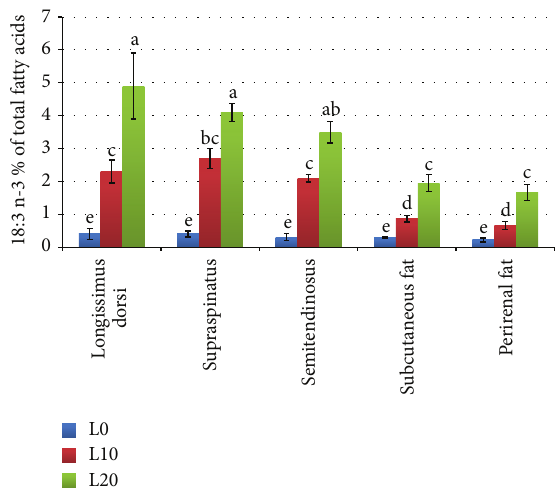
Figure 1: ALA (18:3 n-3) contents in muscles and fat tissues of goats fed diets containing different levels of whole linseed. Error bar = (1SE). Bars with different alphabet notation differ significantly.